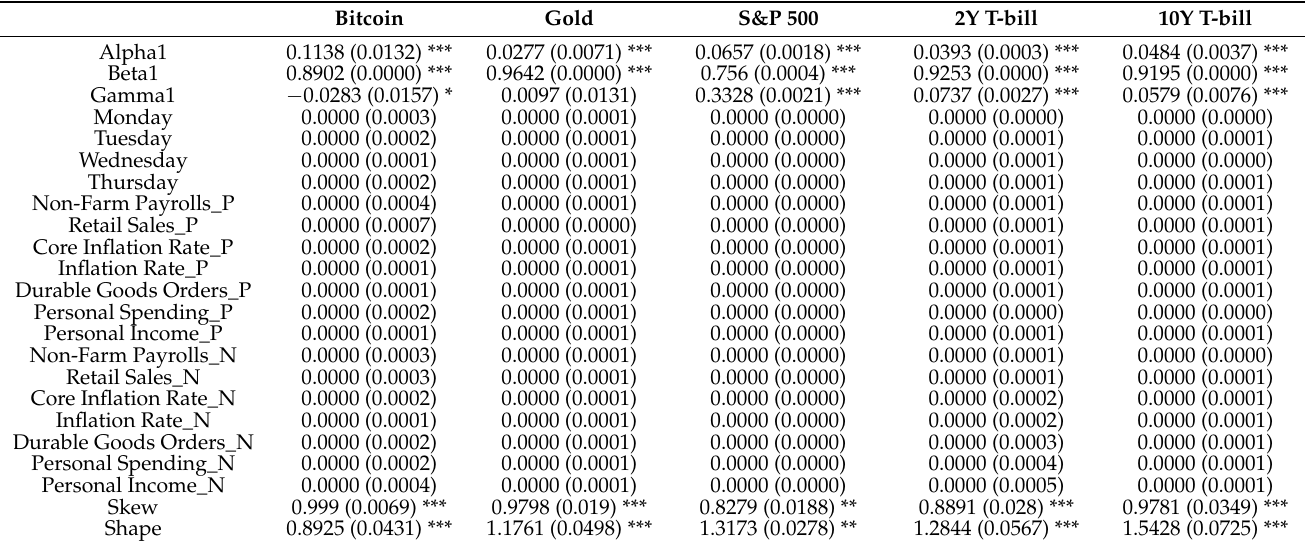
Table 5. Impact of the U.S. announcements on the observed assets’ volatility. Bitcoin